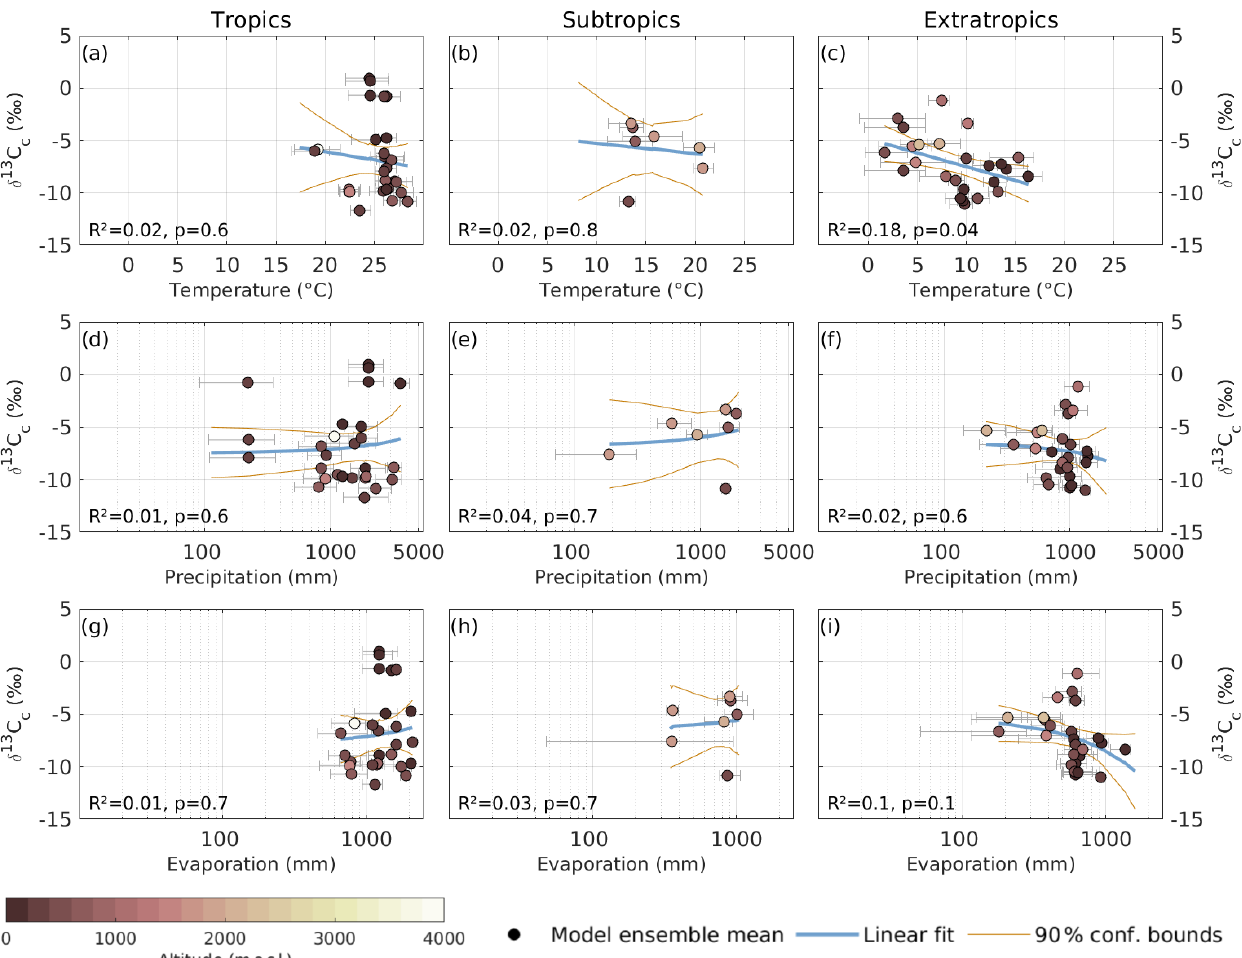
Figure 8. Climate dependence of carbon isotope variability. Shown are simulated ensemble-mean temperature (a–c) , precipitation (d–f) , and evaporation (g–i) plotted against speleothem δ 13 C c . Altitude information is applied as shaded colors in (d) – (i) . We used linear regressions in all plots; however, these appear curved in a semi-logarithmic plot as used for precipitation and